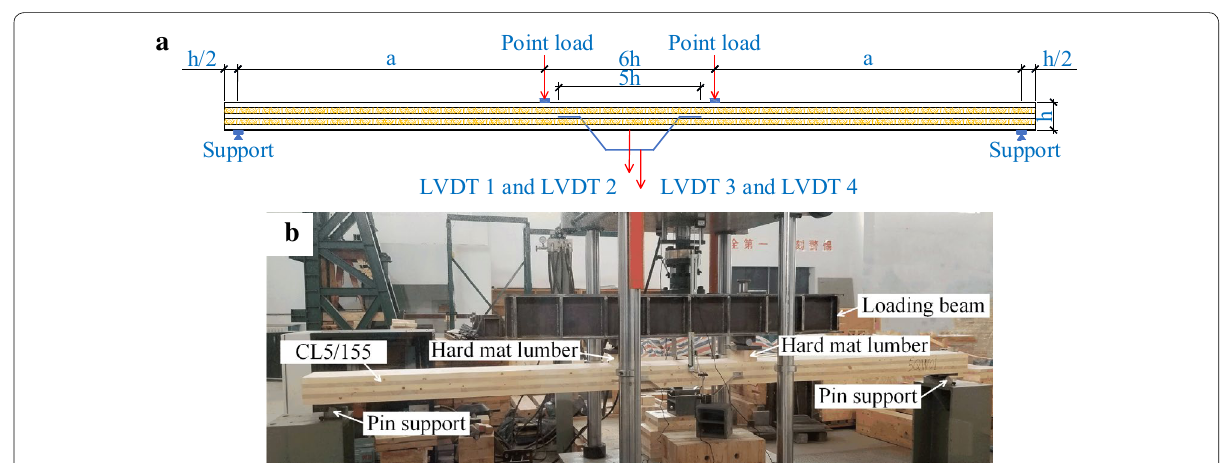
Fig. 3 The CLT bending specimen (5-layer CLT): a loading configurations; b bending test